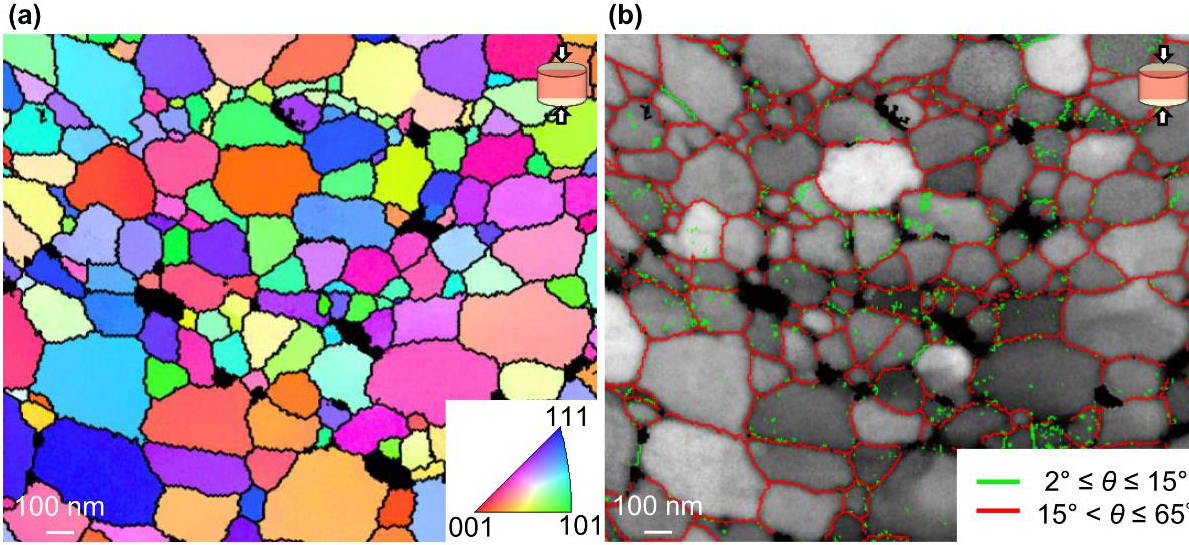
Figure 7. ( a ) TKD inverse pole figure (IPF) map and ( b ) misorientation map superimposed on BC map of unexposed Al compact sintered at 673 K under 600 MPa for 1 min.